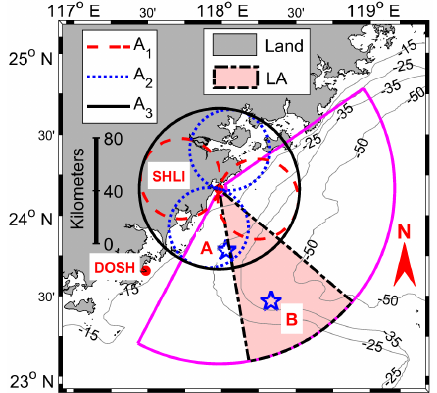
Figure 8. Geographic map of the second field experiment. The radar deployed at SHanLIao (SHLI), where its location is not far from DOSH, has a different antenna configuration with respect to DOSH. The ideal antenna pattern is superposed on the map. The thin gray lines are the isobath. The fanwise area enclosed by the thick pink line is the radar’s detection area and two buoys (blue pentagram) equipped with ADCP were located in the radar’s detection area. The light-pink patched fanwise area is the selected 40-degree local area (LA) for calculating the